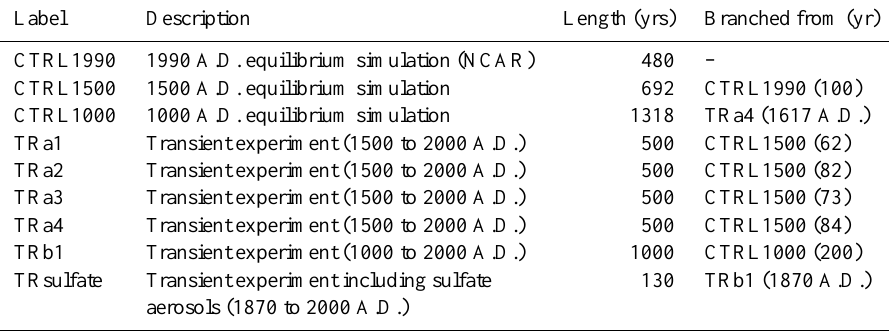
Table 1. List of all experiments. Note that the length for the CTRL1500 and the CTRL1000 simulation also includes the 50 yrs that were not used in the